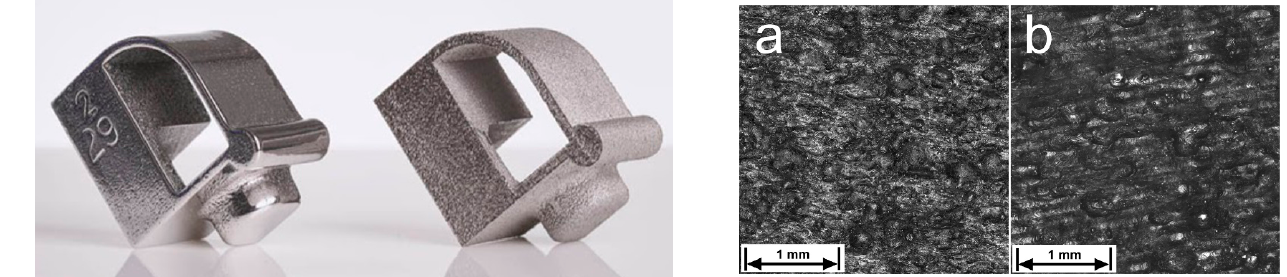
Figure 19. Surface finish before and after postprocessing of AM component (Fintek) [113]. Roughness on surface can be different based on build orientation [114].